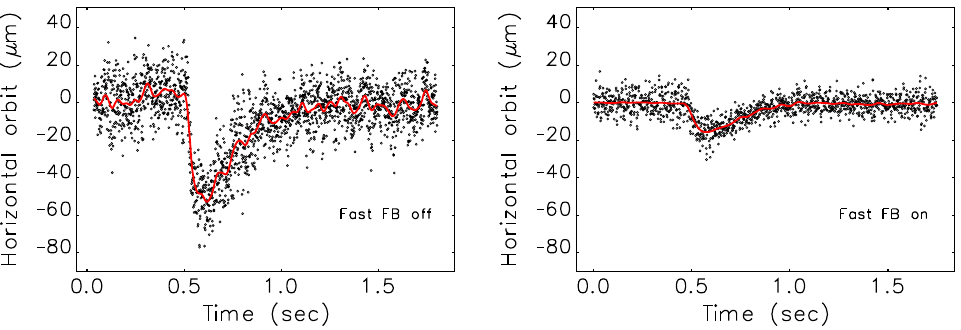
FIG. 19. Effect of induced quench on the beam orbit. Left panel: Slow orbit correction only. Right panel: Fast orbit feedback (FB) turned